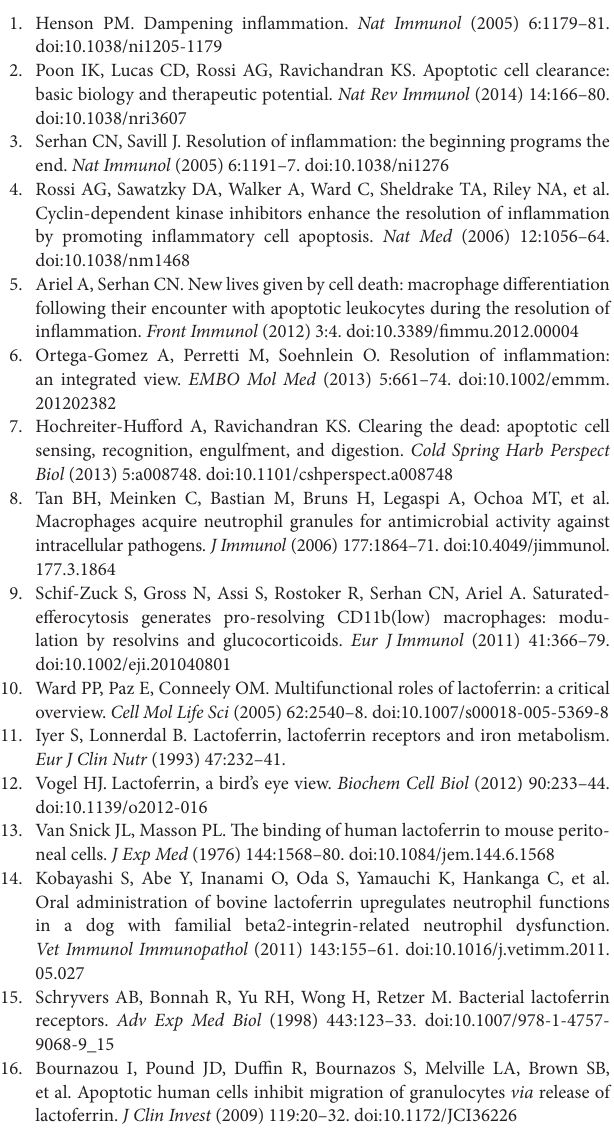
show representative blots from two sample sets taken daily from two different cows. FigUre s4 | Alignment of the identified lactoferrin (Lf)-derived fragments to full-length Lf originated from different species. Protein bands corresponding to the 15- and 17-kDa fragments of Lf were sequenced using trypsin cleavage and mass spectrometry analysis. The sequences of the resulting peptides were aligned and compared to full-length Lf from nine species: Capra hircus , Equus caballus , Ovis aries , Sus scrofa , Camelus dromedarius , Bos indicus , Bos taurus , Homo sapiens , and Mus musculus , using STRAP software. Highlighted in yellow and in bright purple are peptides corresponding to the 15- and 17-kDa fragments, respectively. Positions 1–19 of all sequences (excluding E. caballus ) serve as a signal peptide, and therefore amino acid numbering starts from the 19th amino acid. Peptides produced by serine proteases and reported by Komine et al. (FKECHLA, VPSHAVVAR, FQLFGSP, and PGQRDLLFKDSAL from bovine Lf) are underlined. The sequences in the red frame indicate the minimal consensus sequences in the 17-kDa fragment that were predicted to be